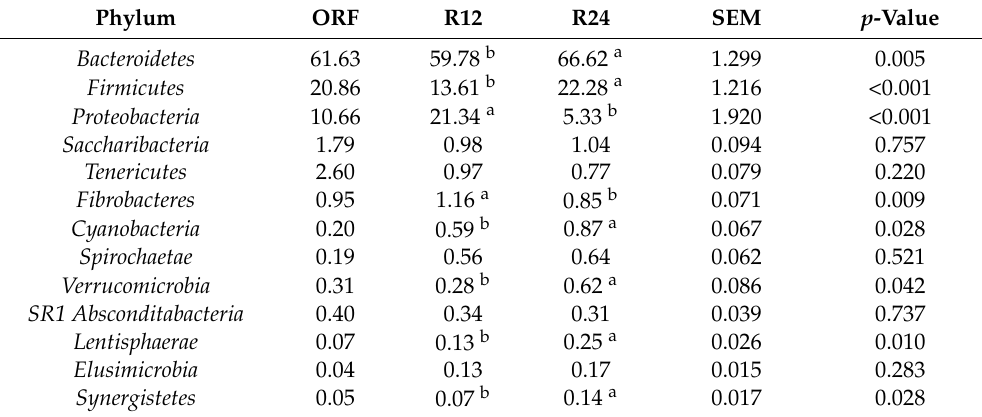
Table 4. Rumen bacterial composition at the phylum level as in vitro fermentation